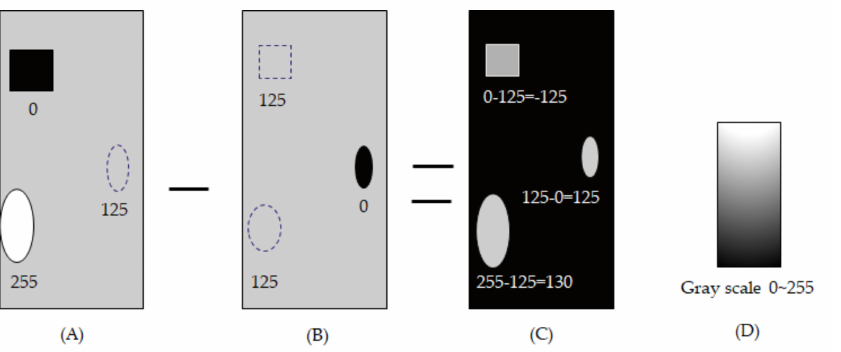
Figure 3. A process of the background subtraction for gray level value, ( A ) shown three defects, ( B ) the background, ( C ) the subtraction, and ( D ) indicator of grayscale. In contrast, the gray intensity is 125, 0, and 125, accordingly. Figure 3A,B indicates the background subtraction for three defects of the morphology from top to bottom as gray square, gray oval, and gray ellipse. In contrast, the gray intensity is − 125, 125, and 130,